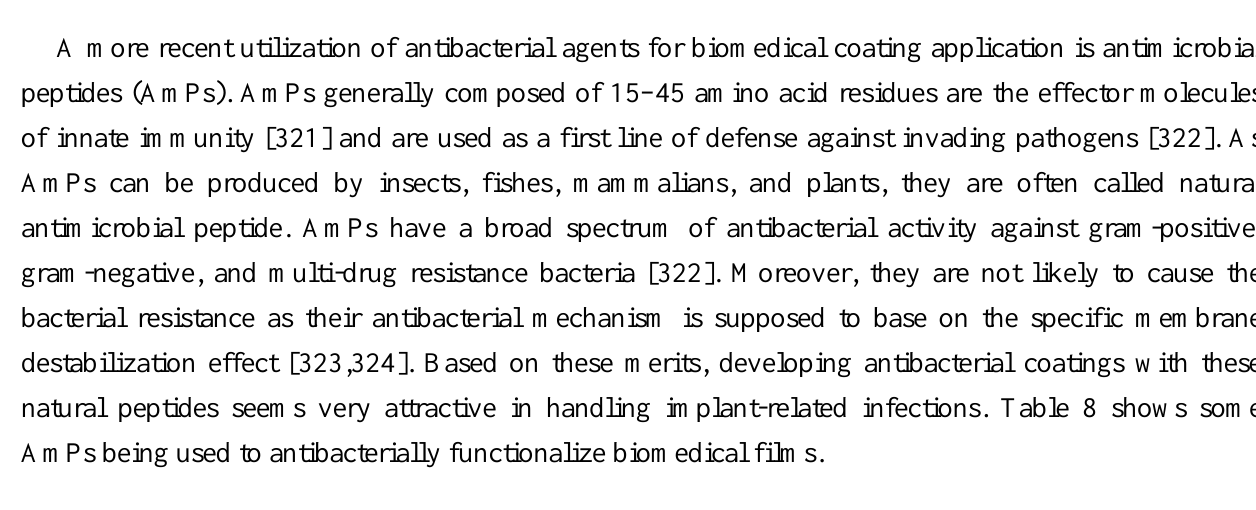
Table 8. Summary of antimicrobial peptides (AmPs) used to functionalize films and corresponding incorporation